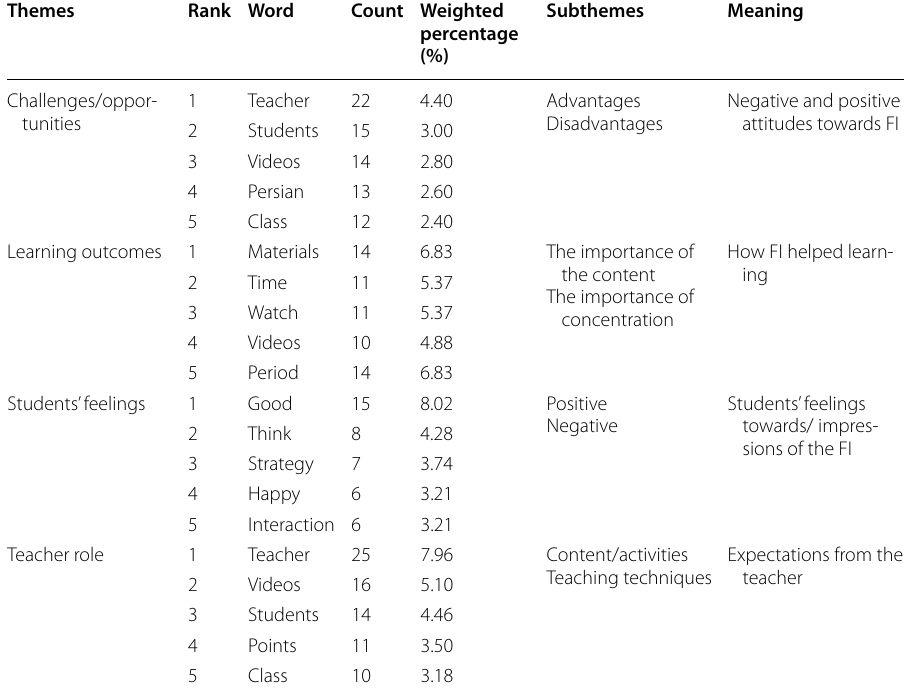
Table 9 Themes and subthemes